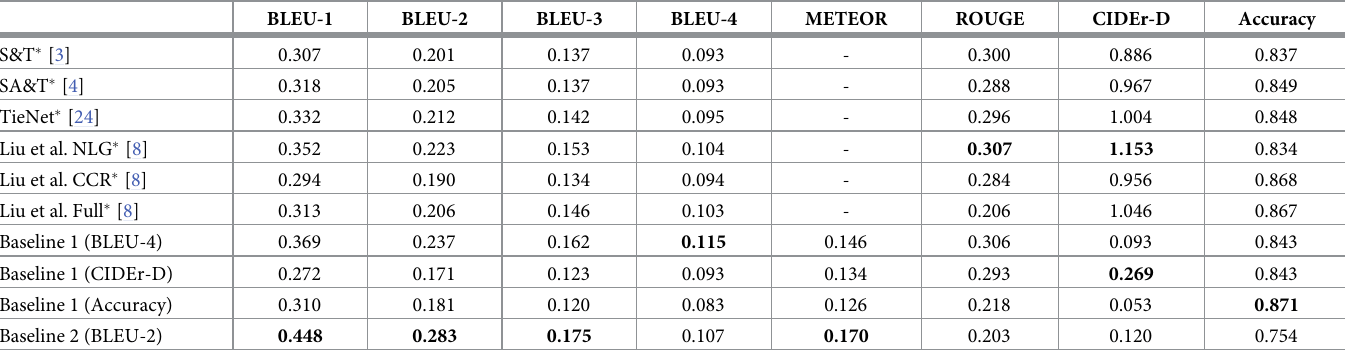
Table 5. Average performance results over test sets on MIMIC-CXR dataset using NLP validation